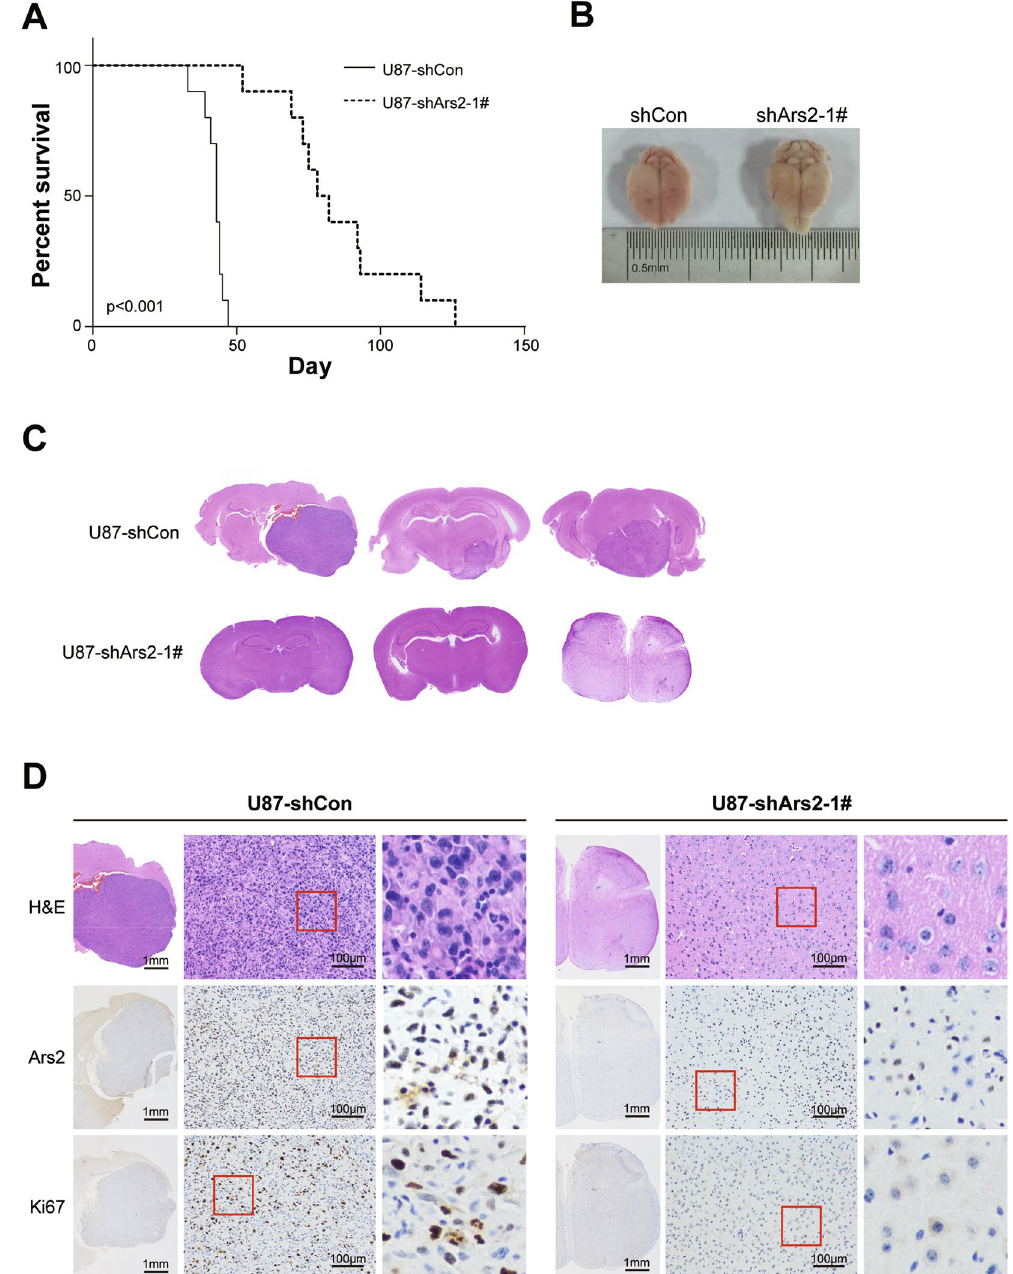
Figure 7. Depletion of Ars2 inhibited tumor growth in orthotopic glioblastoma xenograft model. ( A ) The survival time of U87-shArs2 glioma-bearing mice is significantly improved vs U87-shCon glioma-bearing mice. n = 10, *** P < 0.001 by the log-rank test for significance. ( B ) General observation showed that the brain swelling was presented in the mice of shCon group after 30 days of intracranial incubation. ( C ) Histological examination confirmed much slower tumor development in shArs2 glioma-bearing mice compared to shCon glioma- bearing mice. ( D ) H.E. staining, immunohistochemistry and Ki67 assay were performed to evaluate histological morphology, expression of Ars2, and cell proliferation in brain tissues of U87-shCon and U87-shArs2 glioma- bearing